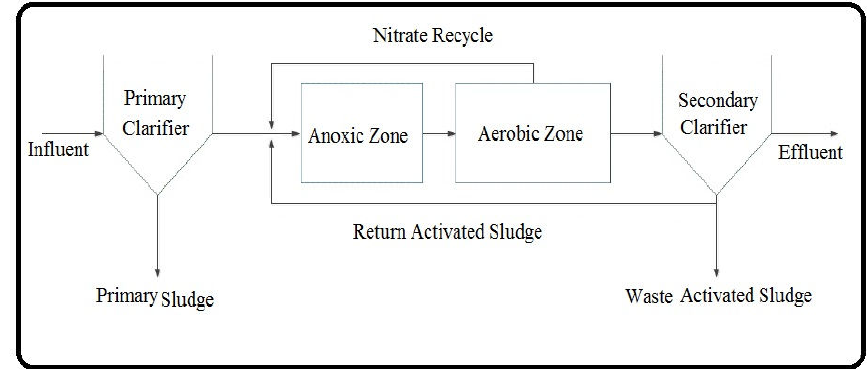
Fig. 1. Flow schematic of MLE